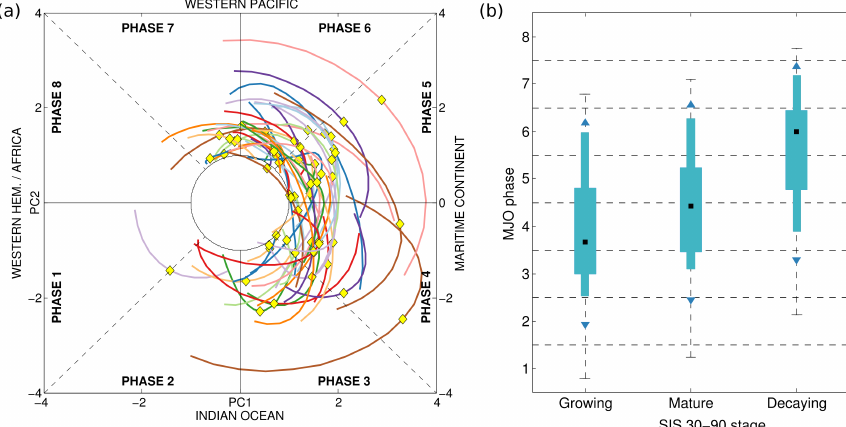
Figure 2. ( a ) MJO phase diagram with the daily MJO index values during positive SIS events within an MJO event. The yellow diamond indicates the day in which the SIS index is maximum and ( b ) Boxplot of the average phase angle for the growing, mature and decaying stages of positive SIS events (see text for definitions). The wide box indicates the lower and upper quartiles, the thin box indicates the 10th and 90th percentiles, the triangles indicate the 5th and 95th percentiles, the black square the median and the whiskers the extreme values. The dashed horizontal lines correspond to the angles in which the MJO phase changes, and the phase associated to each interval of angles is indicated in the vertical